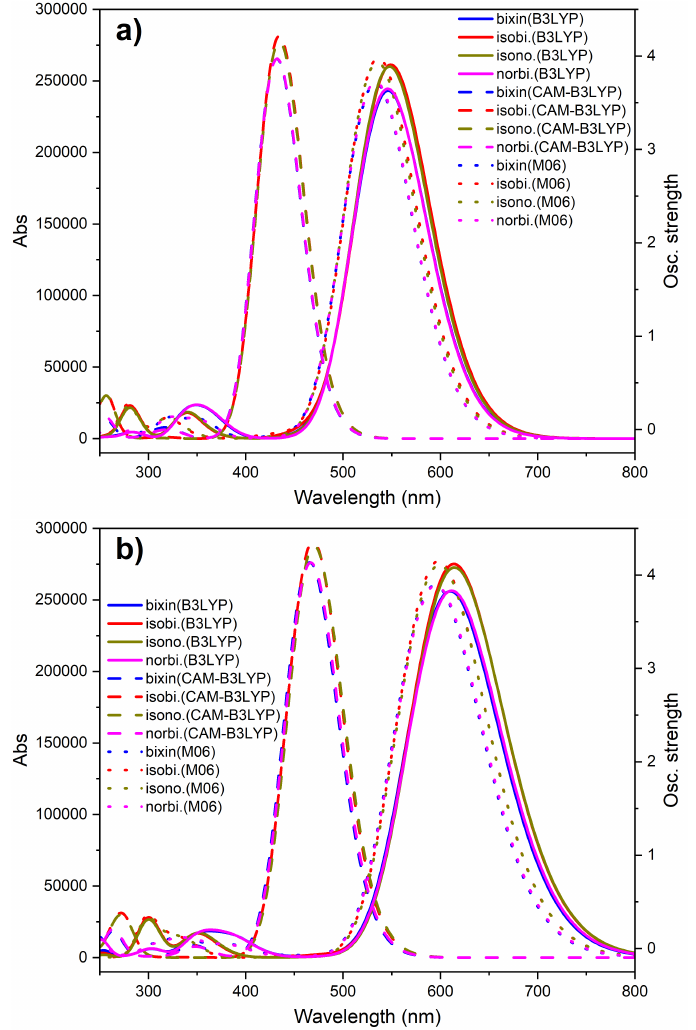
Figure A4. Absorption spectra of molecular dyes in ( a ) gas phase and ( b ) chloroform solution. These results were obtained by employing the 6-31G basis